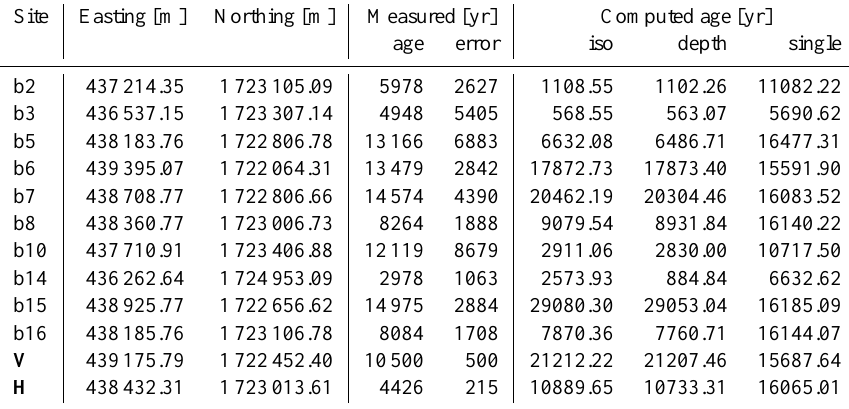
Table 1. Measured calibrated ages at the surface including error in comparison to computed ages for the three different prescribed isotropic (iso), depth-dependent (depth) and the single vertical maximum (single) fabrics. The most reliable measurement points, V and H, are indicated in bold. Coordinate positions are given in UTM29C. Site Easting [m] Northing [m] Measured [yr] Computed age [yr] age error iso depth single